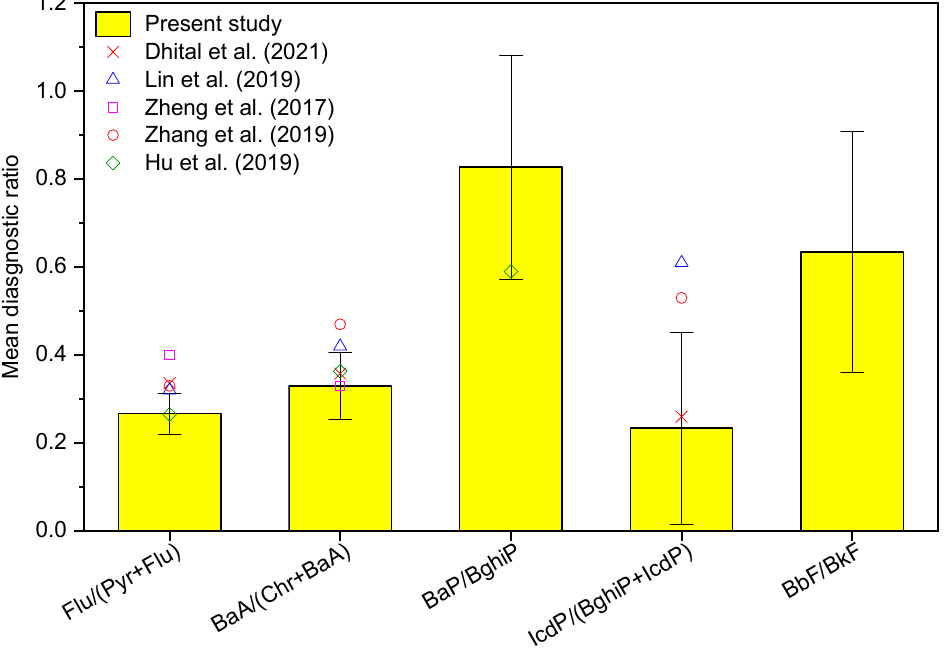
Figure 6. PAH diagnostic ratios obtained in the present study compared with those reported or calculated based on the emission data obtained from the literature [7,19,21,23,24] for various types of on ‐ road and non ‐ road diesel exhaust emissions for diesel exhaust emissions.